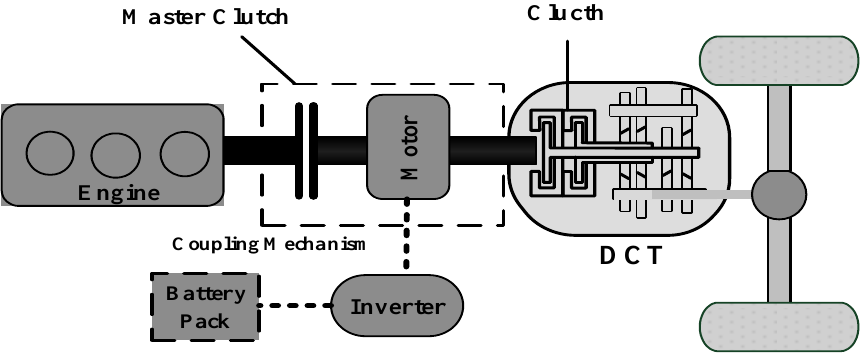
Figure 1. Configuration of the Integrated Starter and Generator (ISG) type Hybrid Electric Vehicle (HEV).